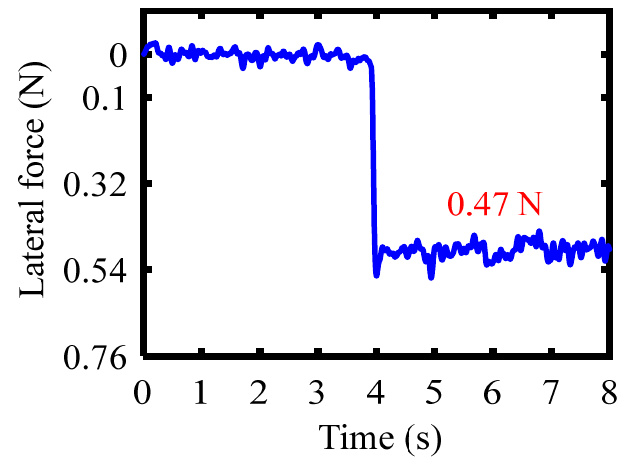
Figure 6. Lateral force–time curves of the original driving foot.